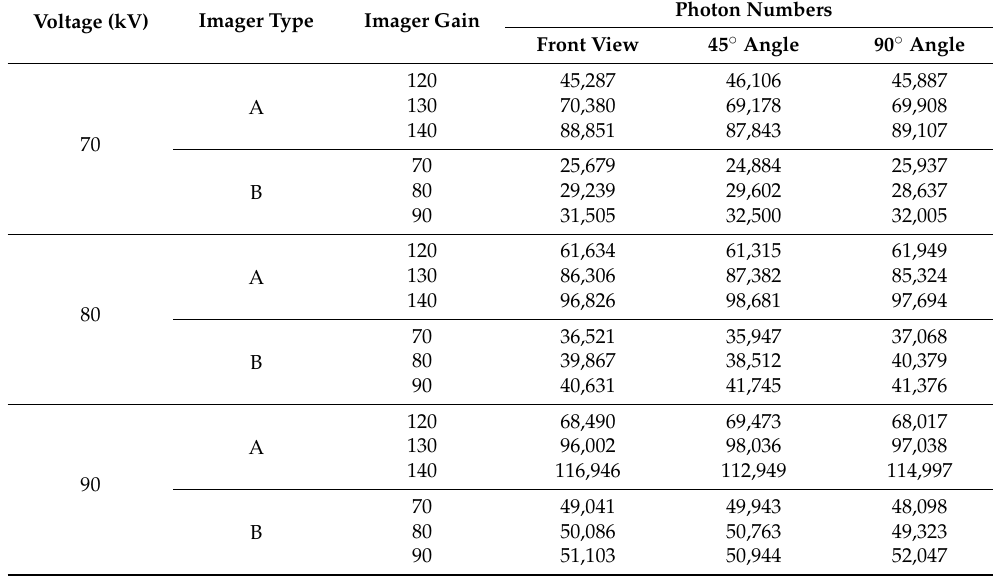
Table 3. Detection results under different observation angles ( p = 98.09 kPa; T = 20 ˝ C; RH =